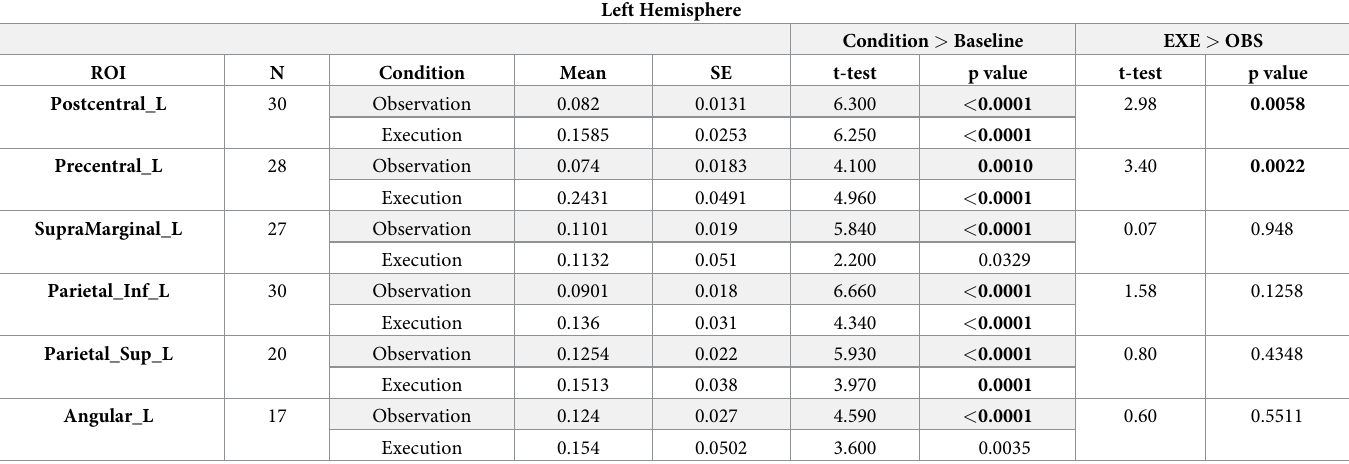
Table 1. HbO2 response to observation and execution conditions in regions of interest (ROI) in the left hemisphere.